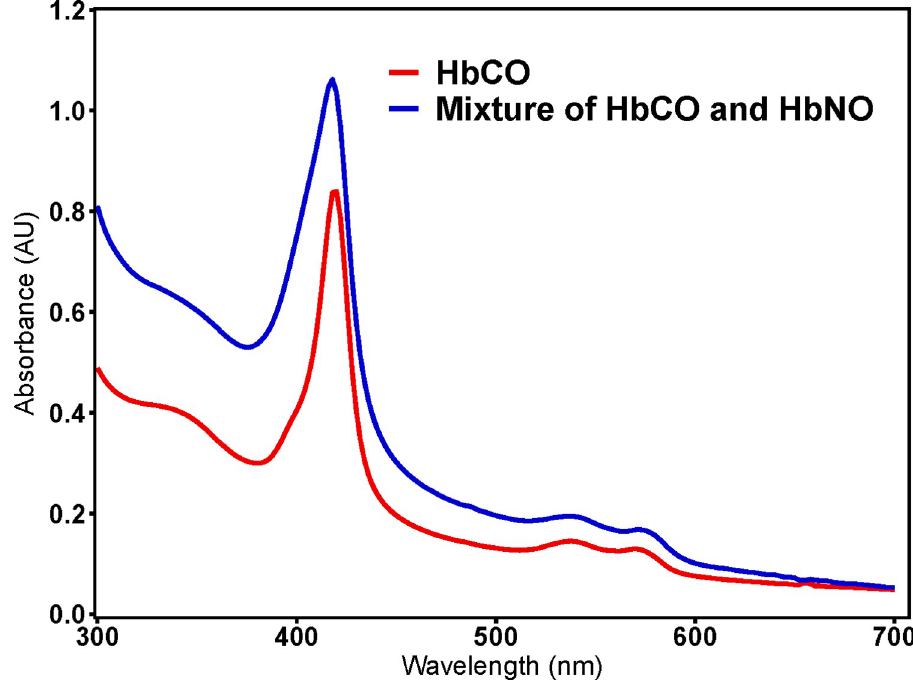
Fig 8. UV-visible spectroscopy of lysed PEG-LEH nanoparticles. A) Soret and (B) Q Bands of NO and CO bound cell free-Hb derived from lysed PEG-LEH nanoparticles encapsulating HbCO (red) and a mixture of HbCO and HbNO